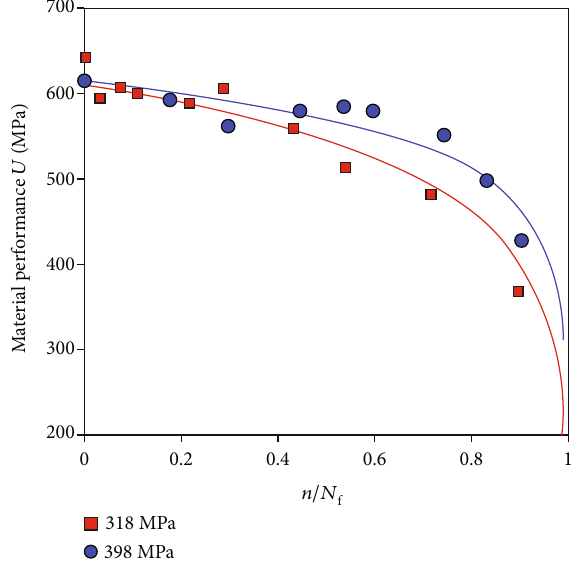
Figure 2: Curve representing degradation of material